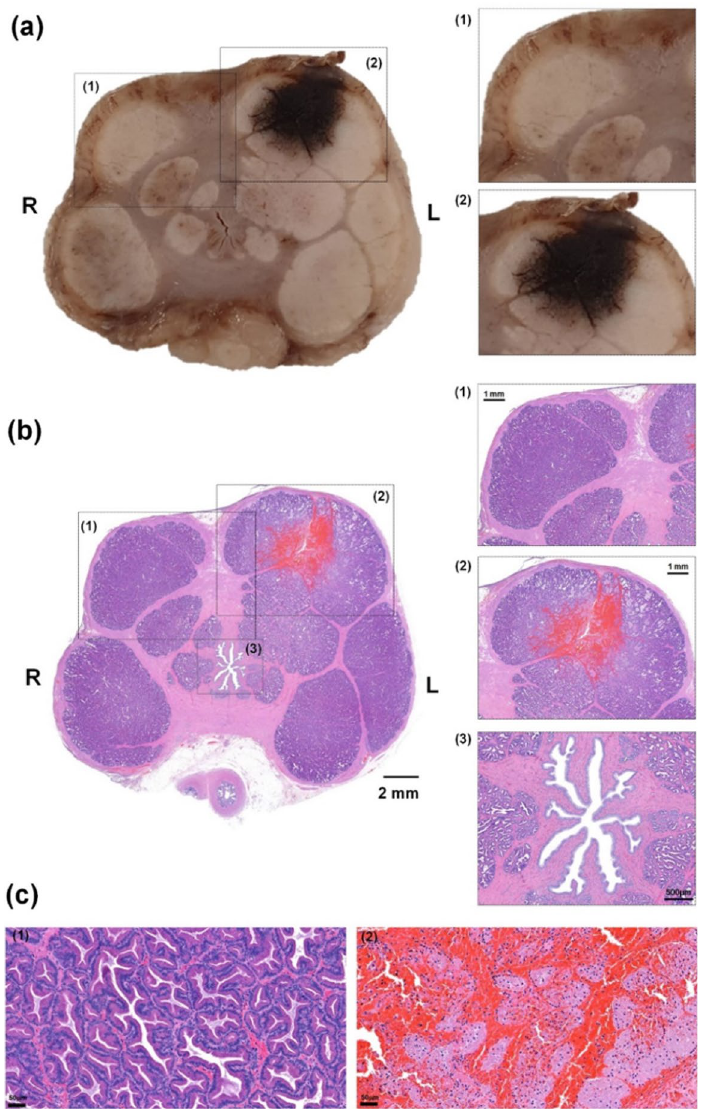
Figure 3. Representative histologic and microscopic images of tissue sections of the beagle exposed to 500 V. ( a ) Gross images with magnification (1, 2) showing necrotic tissue changes and edema on the left side of the ablated prostate. ( b ) Magnified microscopic images showing normal prostate tissue (1), hemorrhage with necrotic changes (2), and the prostatic urethra (3). Histologic staining of an ( c ) intact (1) and an IRE-treated (2) tissue